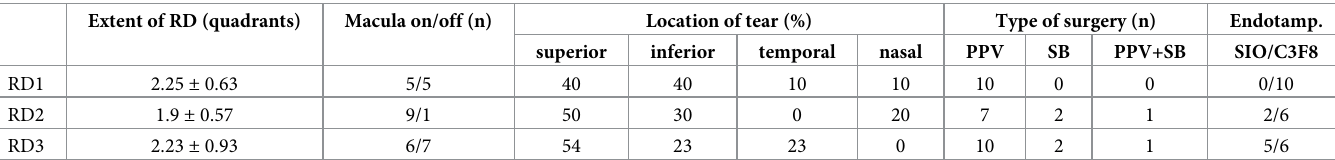
Table 2. Retinal detachment